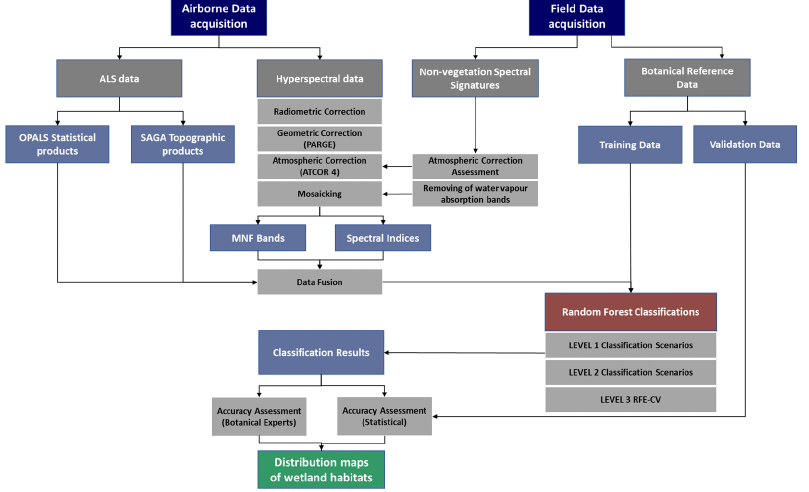
Figure 4. The simplified workflow of the methodology.